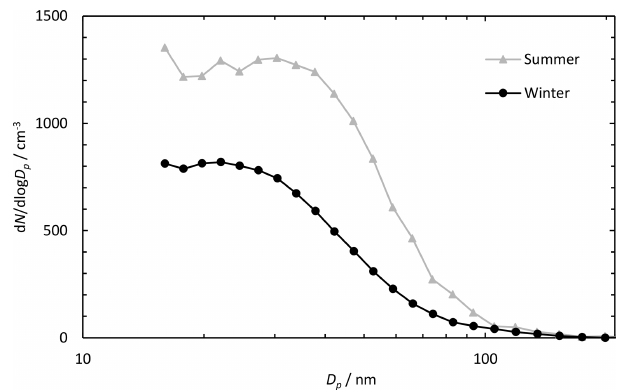
Figure 7. The ship contribution to the average size distribution of particles (diameter, D p , from 15 to 200nm), measured with an SMPS during winter ( n = 113) and summer ( n = 8) respectively. Ambient background concentrations have been subtracted for each plume event, and correction for particle losses in the sampling has been accounted